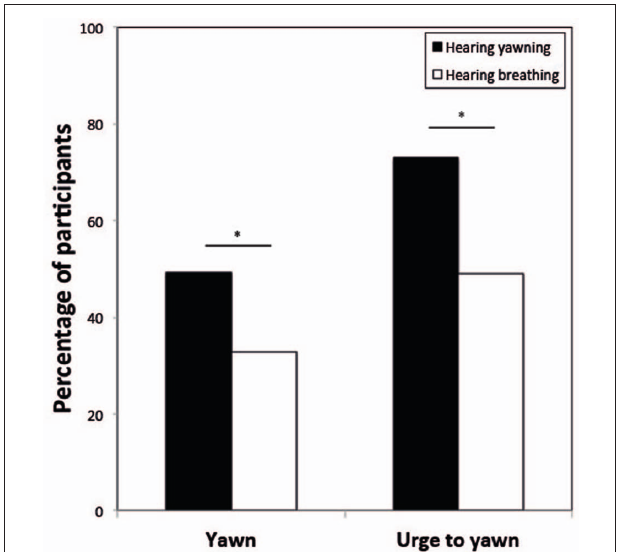
FIGURE 2 | Proportion of trials showing pictures of low status politicians (black bars) or high status politicians/former presidents (white bars) in which participants yawned or had the urge to yawn. * p <